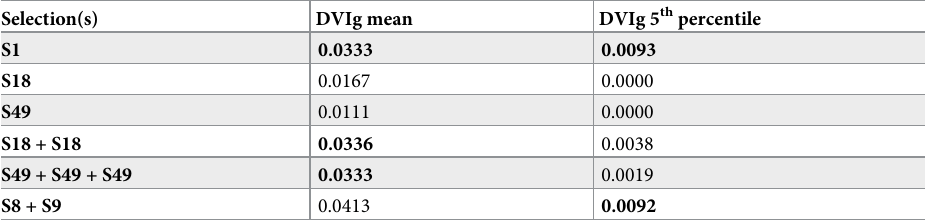
Table 1. Examples of risk and mean equivalence with